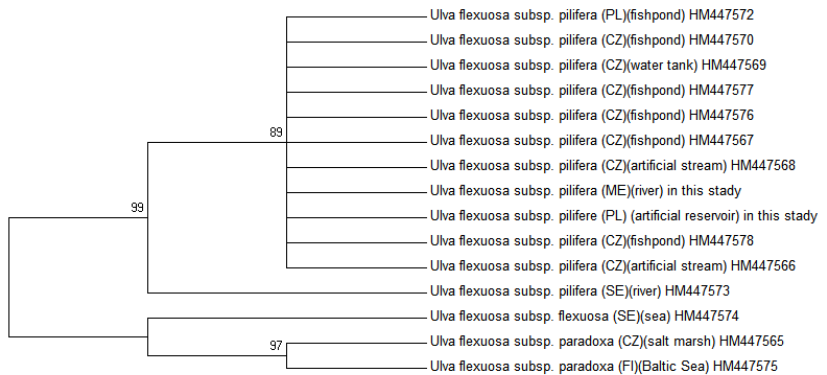
Figure 6. Maximum likelihood tree of rbc L DNA sequences U. pilifera samples obtained from Montenegro and Poland. Numbers on branches represent bootstrap support analysis 1000/50. The phylogenetic tree was constructed by ML algorithm of the MEGA 6 program. Location and habitat of Ulva species taken from Mareš et al. [12].